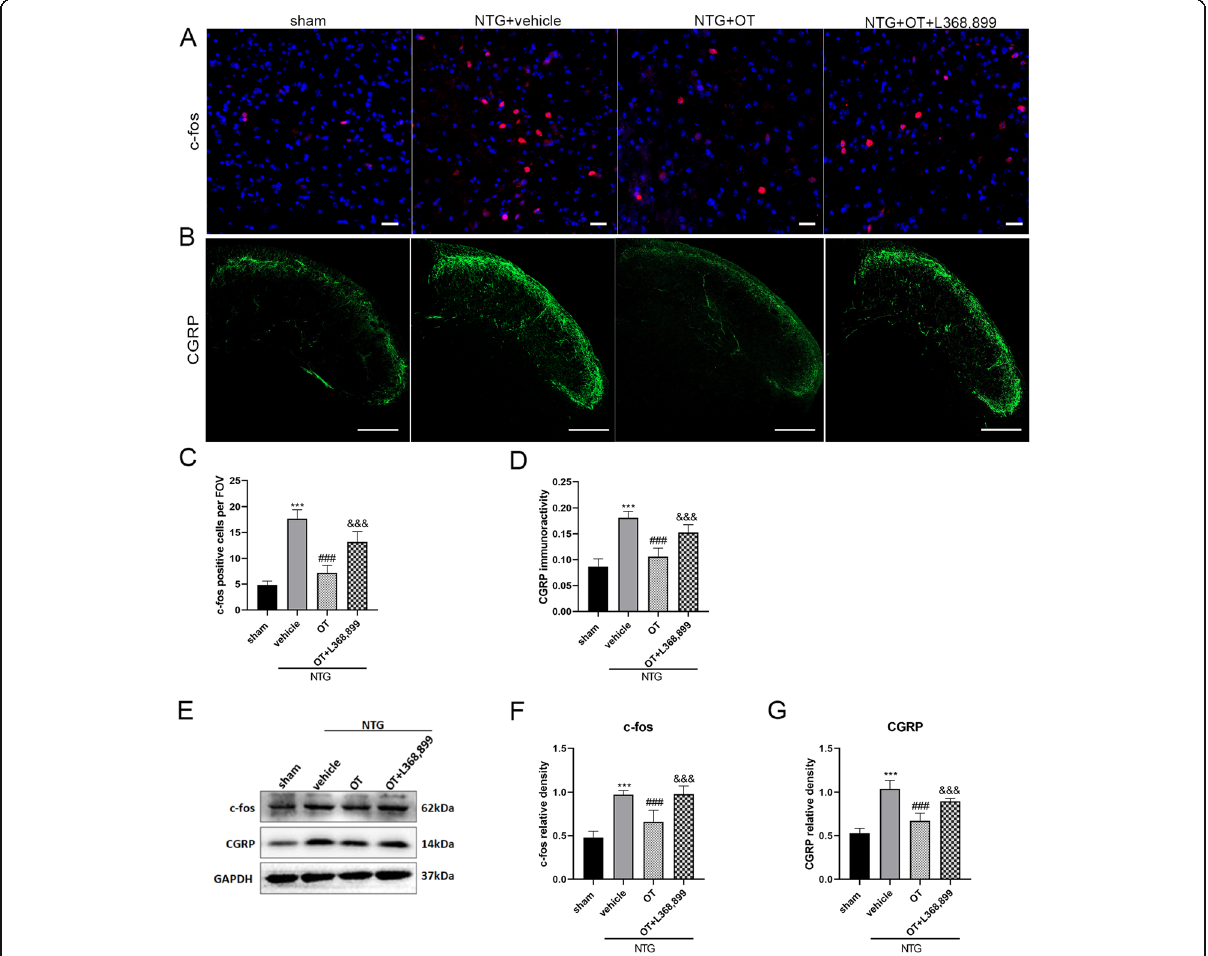
Fig. 4 Effect of OT on CGRP and c-fos expression levels. A and C show c-fos, B and D show CGRP. Immunofluorescence staining showed that the number of c-fos-positive cells per FOV and the average fluorescence intensity of CGRP were significantly increased in the NTG + vehicle group compared with the sham group. OT administration significantly reduced the expression of CGRP and c-fos, while these effects were prevented after adding L368,899 (scale bars: 20 μ m for c-fos, 100 μ m for CGRP). E , F and G WB data quantification showed similar results to the immunofluorescence staining results. One-way ANOVA with Dunnett ’ s post hoc test, n = 4/group for immunofluorescence analysis, n = 6/group for WB analysis; *** p < 0.001 vs. the sham group; ### p < 0.001 vs. the NTG + vehicle group; &&& p < 0.001 vs. the NTG + OT